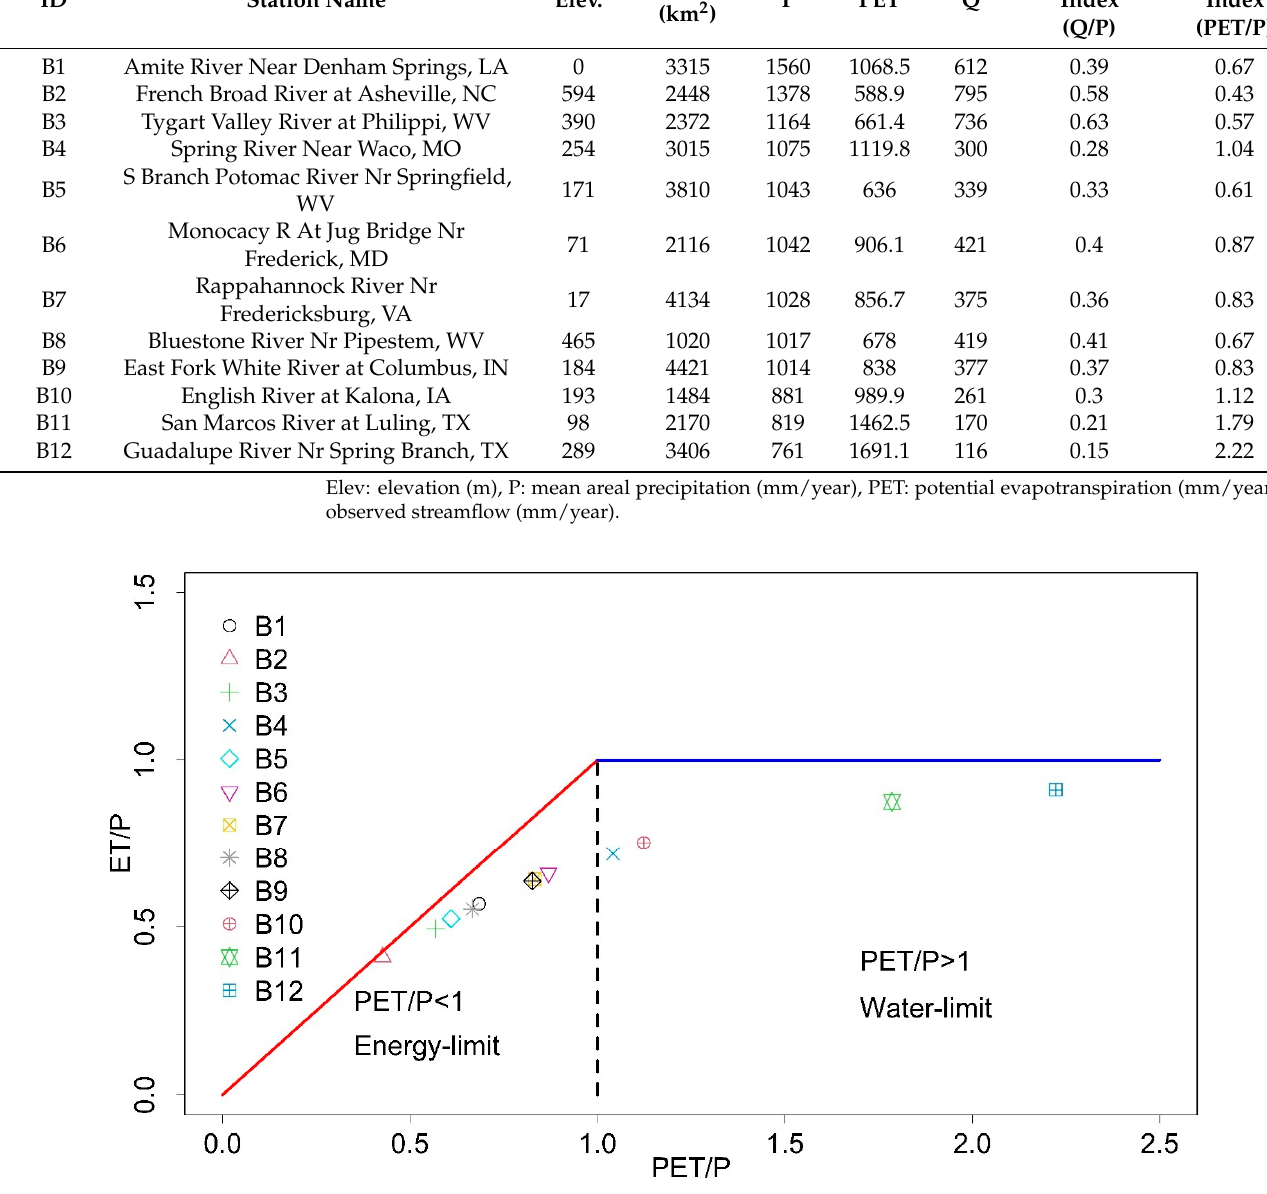
Figure 3. The Budyko curve for the 12 catchments selected from MOPEX. The values to reproduce the figure came directly from the MOPEX